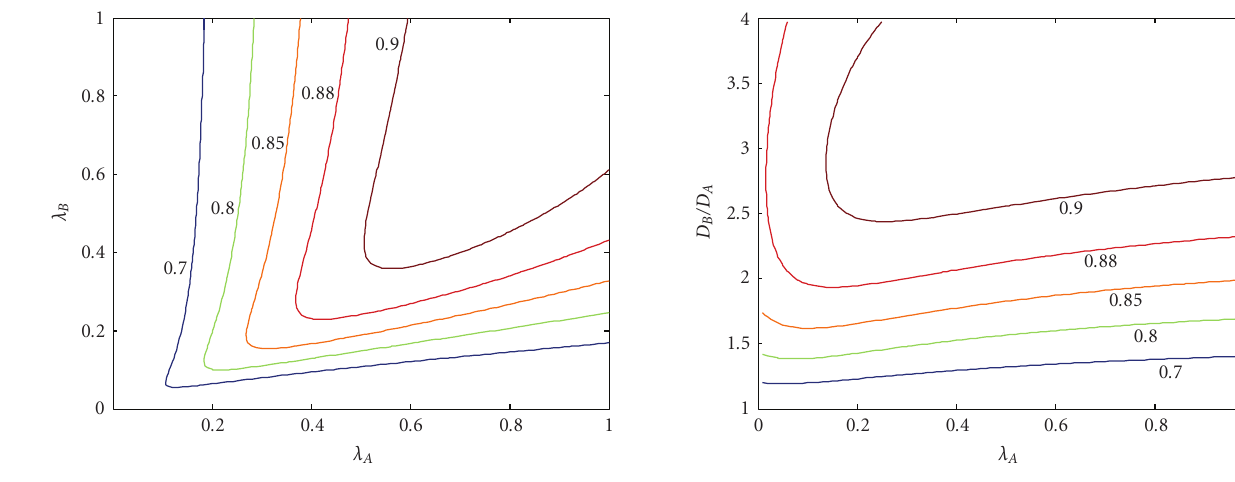
Figure 6: Contour of turbine e ffi ciency.